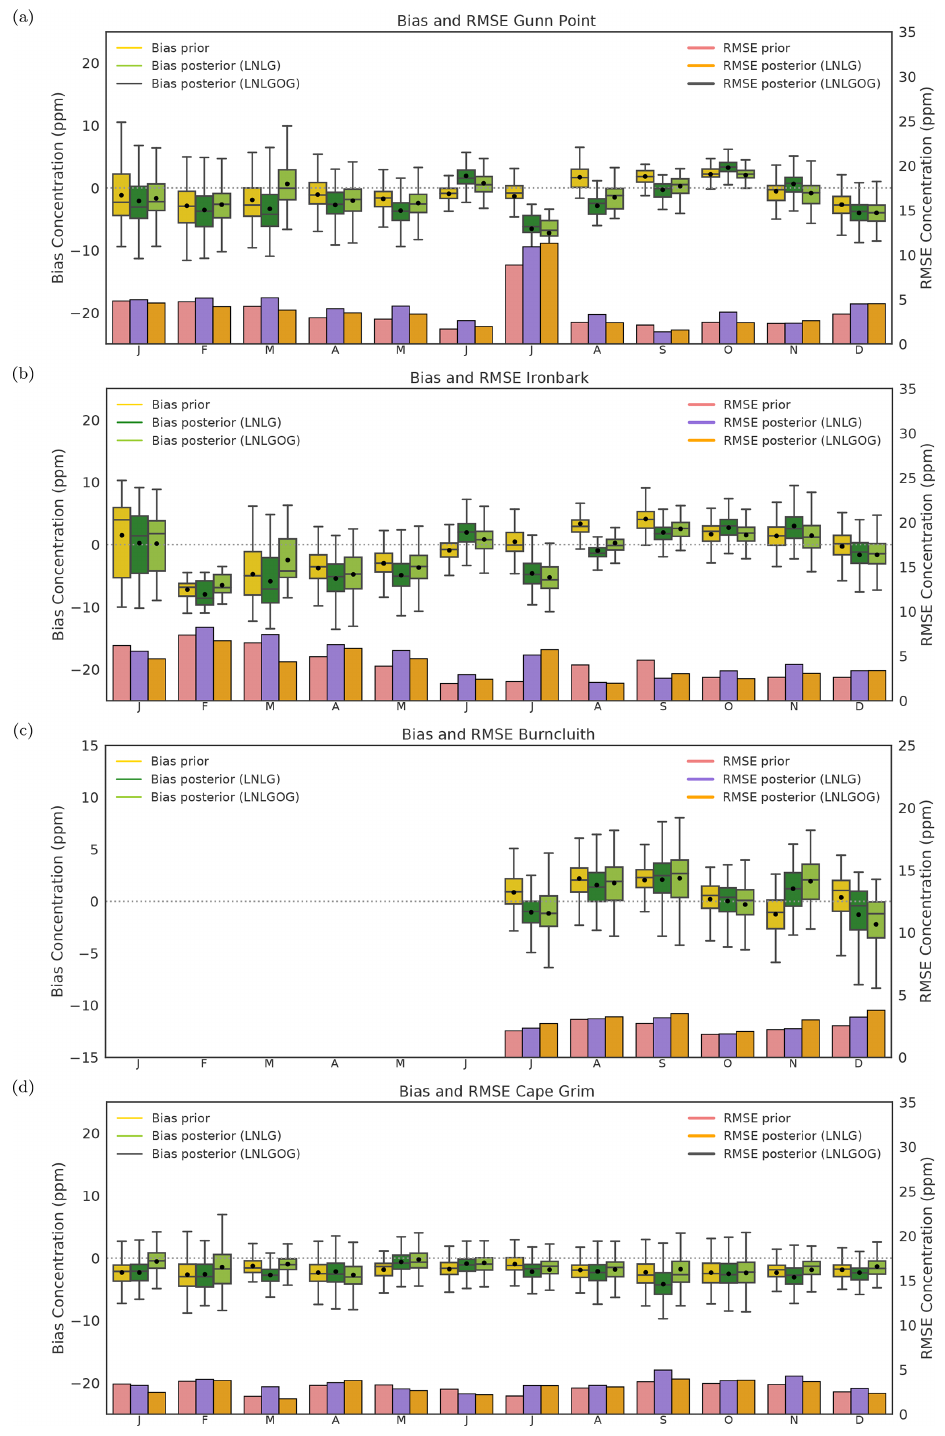
Figure 13. CMAQ prior and posterior concentration bias and root mean square error at (a) Gunn Point, (b) Ironbark, (c) Burncluith and (d) Cape Grim for 2015. For details of what the different components of the box plot represent, see the caption of Fig. 11. Note that bias and RMSE in Gunn Point in July exclude the highest concentration value for that period, which was 558.408ppm; we did this to better represent the figure. Prior and posterior concentration biases for this period were − 4.9 (RMSE = 16.8) and − 5.1ppm (RMSE = 17.1),